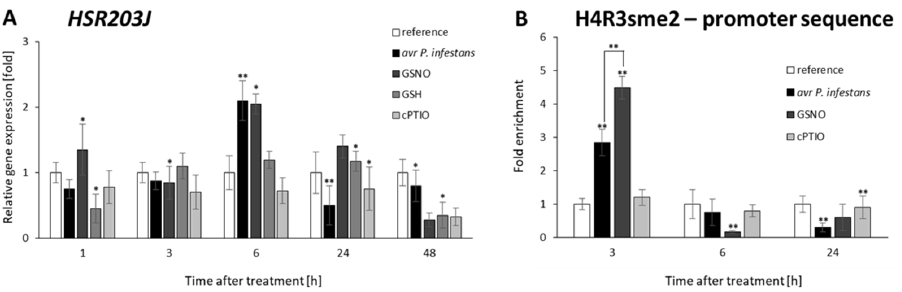
Figure 7. Analysis of HSR203J (hypersensitive marker) gene expression ( A ) and time-dependent distribution levels of H4R3sme2 on the promoter of HSR203J ( B ). RT-qPCR gene expression of CLF was analyzed in potato leaves (at 1–48 h) after treatment with GSNO, GSH, cPTIO, water, or avr P. infestans inoculation, respectively. ChIP–qPCR analyses were performed in potato leaves at selected time points (3–24 h), after treatment with GSNO, GSH, cPTIO, water, or avr P. infestans inoculation, respectively. Data are presented as X-fold enrichment [55]. The relative amounts of immunoprecipitated chromatin fragments (as determined by real-time PCR) from the above variants of treatment were compared with the reference (arbitrarily set to 1). Each experiment included at least three independent measurements per sample. P values for each sample combination were calculated using ANOVA and mean values were compared using the Tukey–Kramer test ( α = 0.05 (*) and α = 0.01